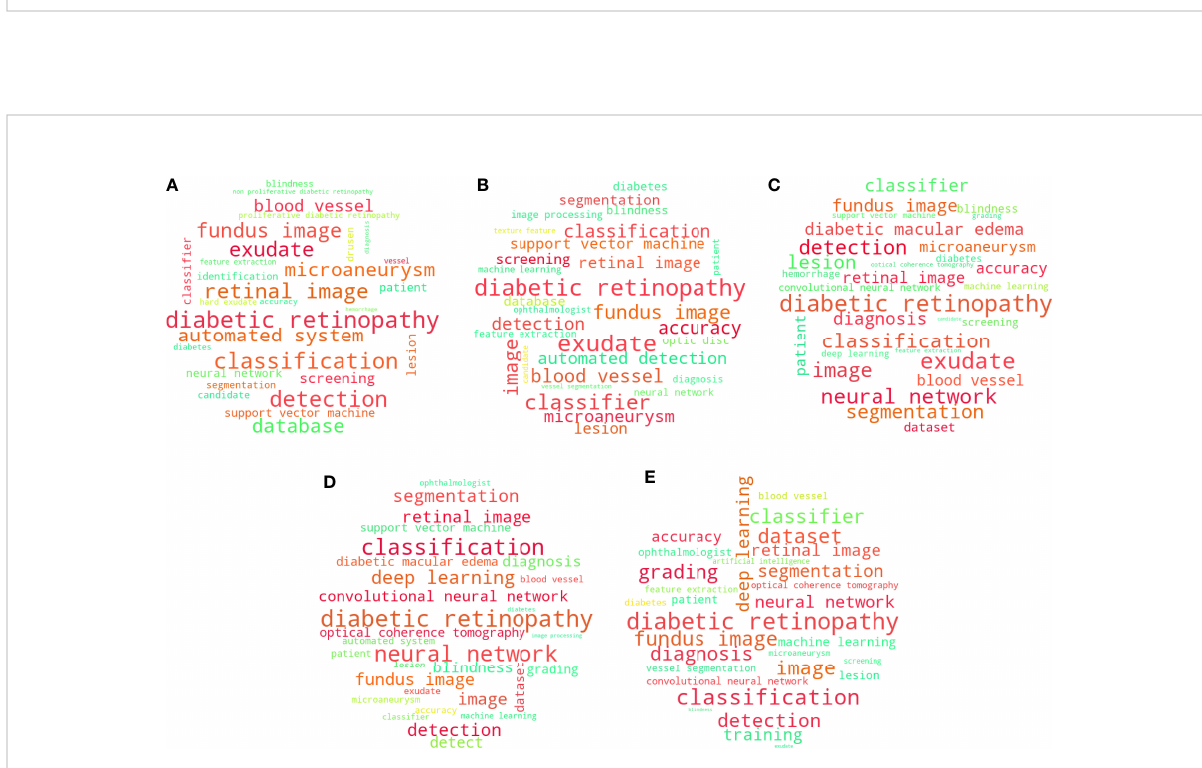
FIGURE 5 Cloud maps of keywords in 5 periods (the top 30 most frequently-occurred keywords in each map, red keywords are more dominant, green keywords are less dominant): (A) during periods 2011-2013; (B) during periods 2014-2015; (C) during periods 2016-2017; (D) during periods 2018-2019; (E) during periods